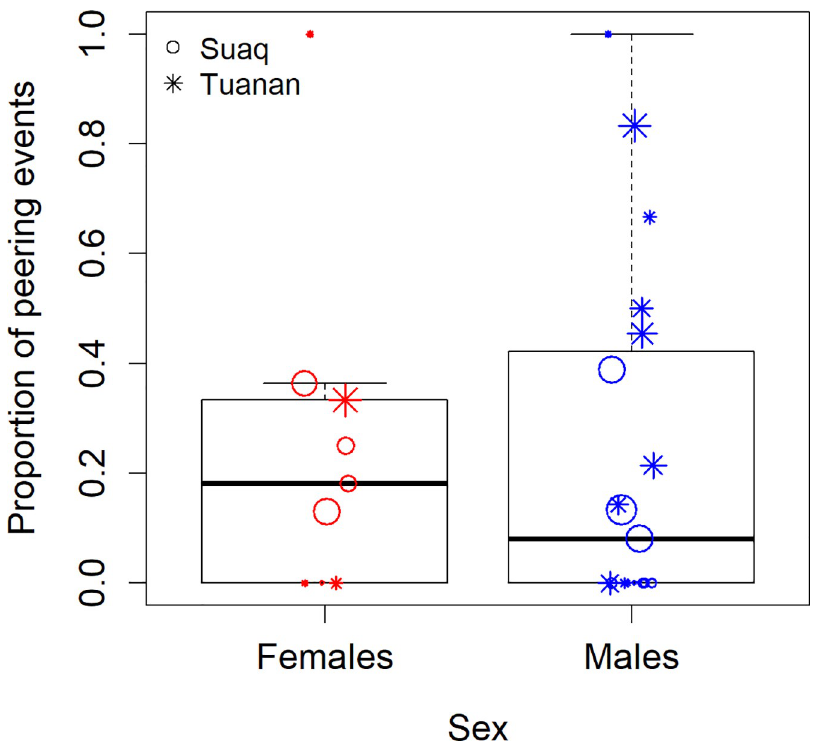
Fig 4. Non-subsistence peering: Proportion of all peering events outside of the feeding context that was directed at non-mother targets by immature females and males at Suaq and Tuanan. The symbol sizes correspond to the number of peering events per data point ( N = 28 peering proportions based on a total of 479 peering event with 157 events by immature females and 322 events by immature males). The underlying data for this figure can be found in S1